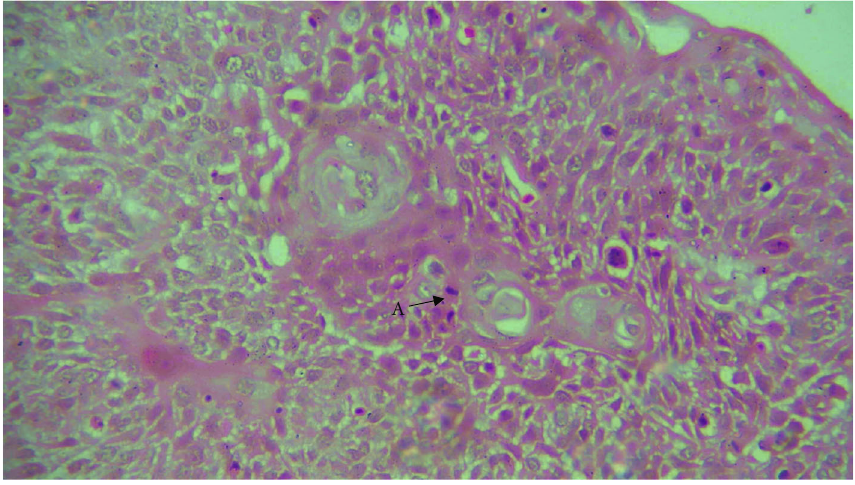
Figure 2: 40 × view. A: mitotic fi gure.